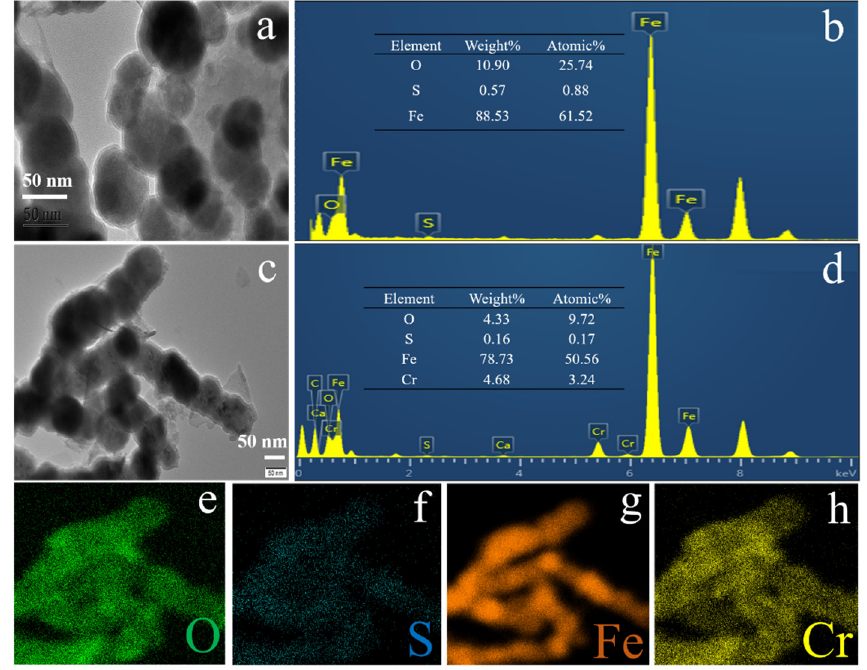
Figure 3. ( a , b ) TEM image of S-nZVI@OS and corresponding EDS images before reaction; ( c – h ) TEM image of S-nZVI@OS and corresponding EDS mapping images after reaction.